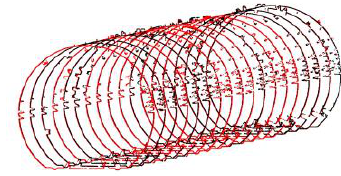
(black dots) and the rotated cross sectional point sets (red dots) when rotation of the cross sectional plane are +2 0 .